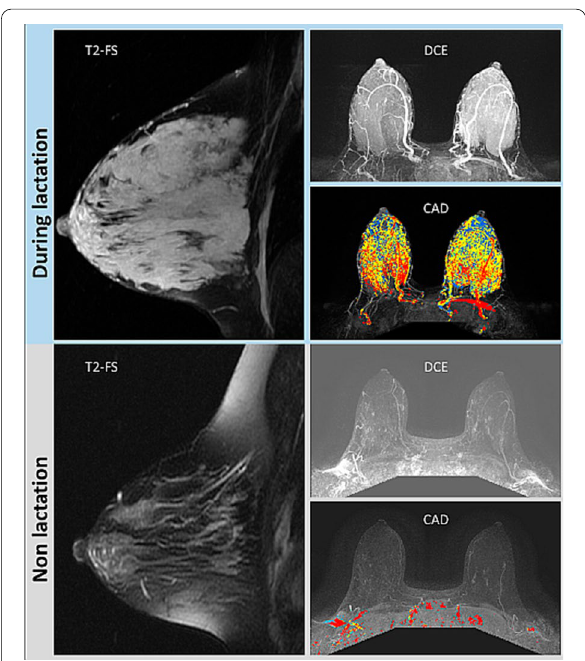
Fig. 2 Changes of breast MRI properties during lactation. MR images of a BRCA carrier scanned twice at the age of 37, while lactating for 4 months (upper panel), and 2 years afterwards, post‑weaning (lower panel) are presented. The sequential examinations demonstrate the marked changes in the breast composition and vascular properties between the two periods. A rich fibroglandular tissue, which is exhibited during lactation, reduces dramatically post weaning. Respectively, the breast perfusion reduces considerably, from BPE 3 to BPE 1, as shown on DCE subtraction MIP images, as well as on DCE CAD maps. Add DCE MIP